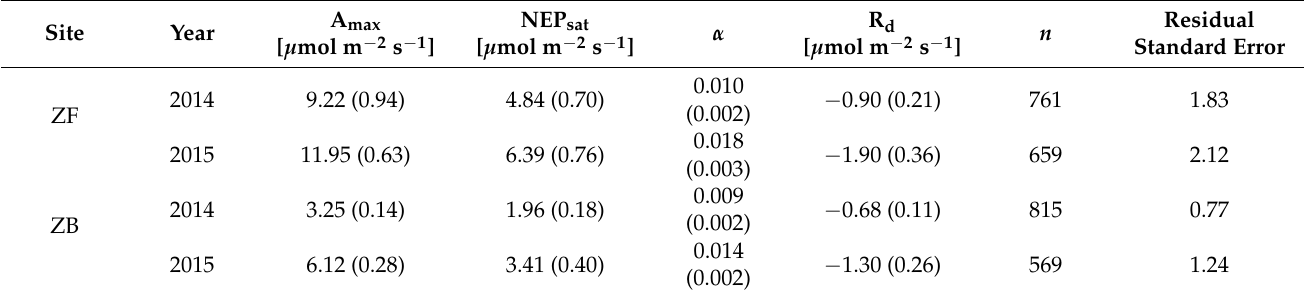
Table 4. Model parameters of the rectangular light-response function for the year with the most frequent cold weather days (2014) and for the year with the least frequent cold weather days (2015) for both ZF and ZB. Numbers in parentheses denote the standard errors of the parameters. n is the number of half-hourly data. As NEP sat is a function of A max , 𝛼 , R d , and PAR at saturation